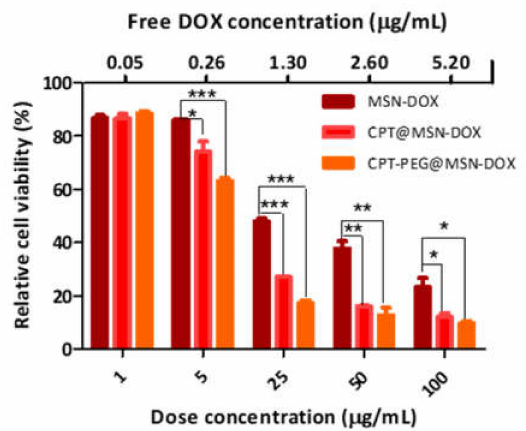
Figure 7. Cell viability of HepG2 incubated with MSN-DOX , CPT@MSN-DOX , and CPT-PEG@MSN-DOX for 72 h. Data represented as mean ± SD ( n = 3), * p < 0.05, ** p < 0.01, and *** p < 0.0001. The concentration of free DOX is the released drug at pH 6.5. The concentration of free DOX was estimated as the released drug at pH 6.5 by CPT-PEG@MSN-DOX